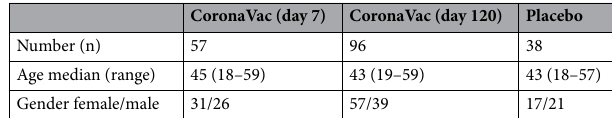
Table 1. Data of the volunteers enrolled in the